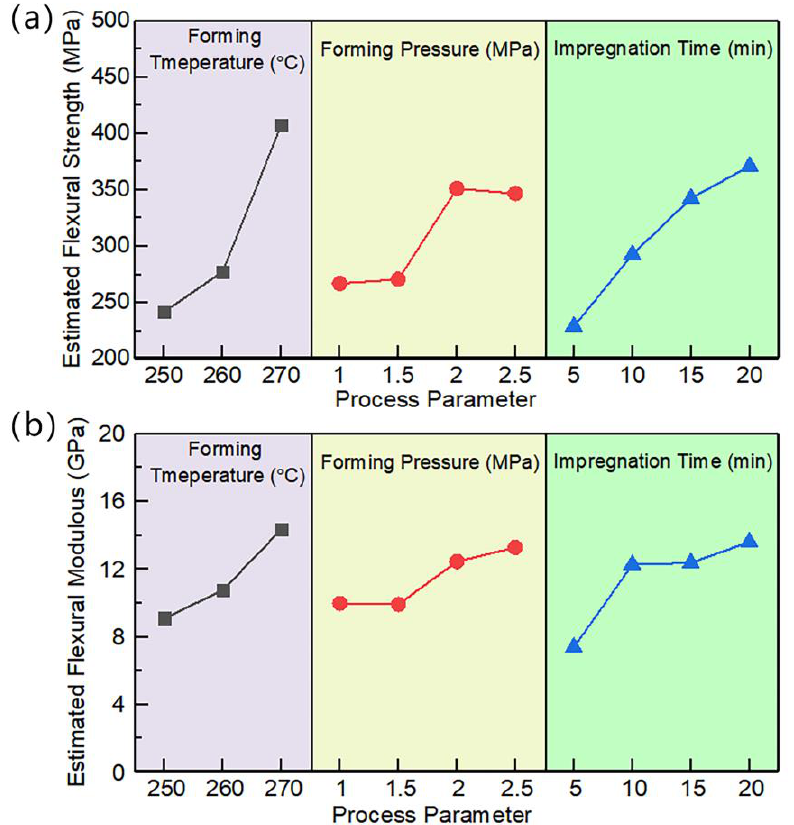
Figure 8. The effect of process parameters on the flexural properties: ( a ) flexural strength; ( b ) flexural modulus.